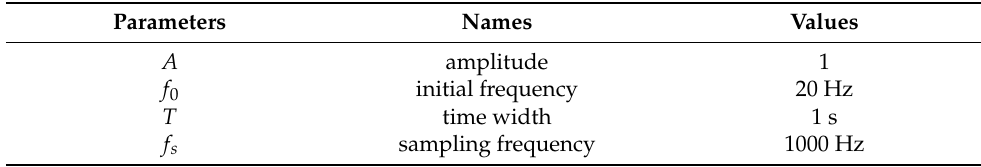
Table 1. An analysis of the SEST process of the harmonic signal is shown in the figure below. Table 1. Parameters of the harmonic signal. Parameters